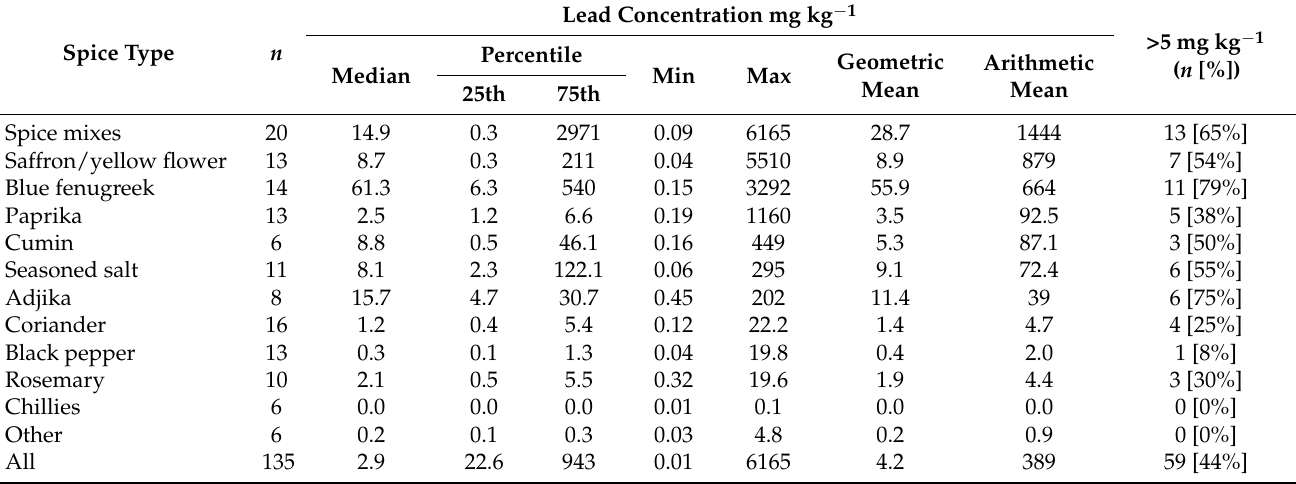
Leaded paint is a well-documented source of Pb exposure and as such, has been Table 3. Summary of spice Pb banned in many countries. The present study analysed 22 paint samples that were shown